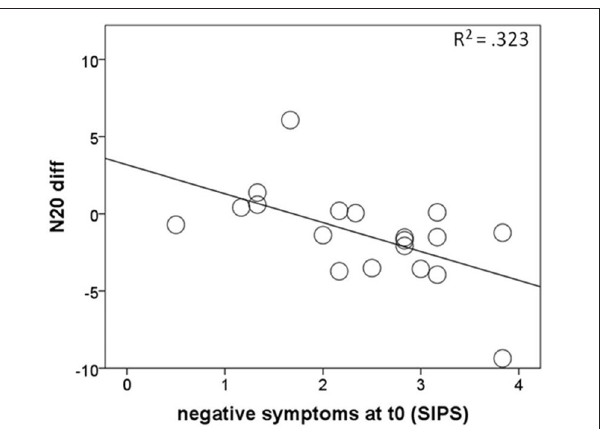
FIGURE 3 | Correlations of negative symptoms at baseline with the amount of N20 strength decrease over time (N20 diff) in cannabis non-users from the RISK group, with negative values representing smaller values at follow-up than at